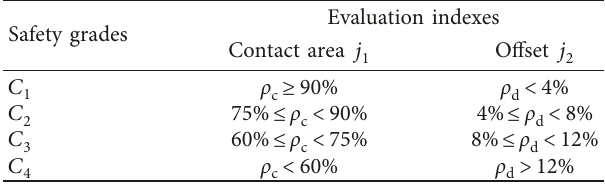
Table 8: Classification standards and evaluation indexes for plinth.